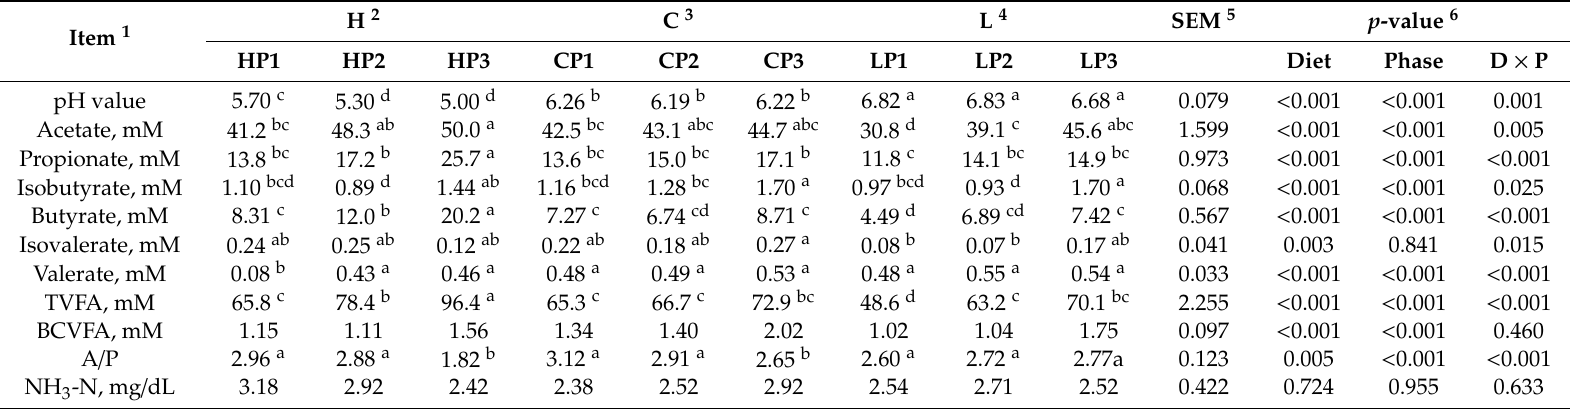
Table 2. Fecal pH Value, Volatile Fatty Acid and Ammonia Nitrogen Concentration of Holstein Steers Fed with Three Stepwise Density Diets.